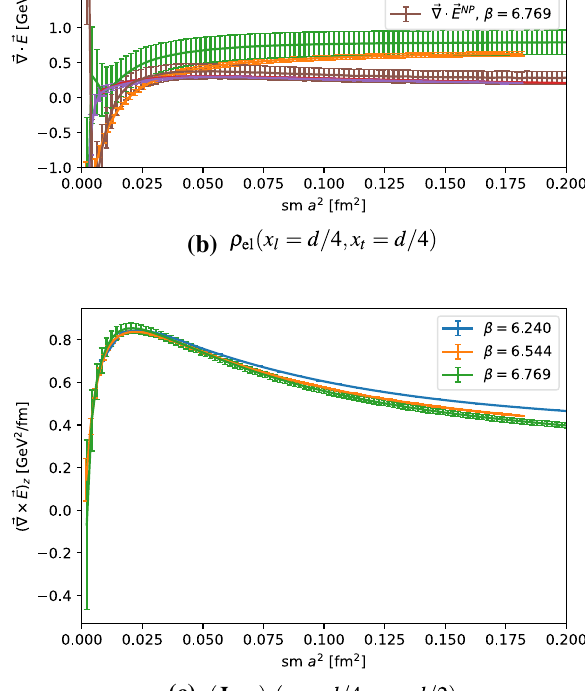
values of the coupling and of the optimal number of smearing steps, are in good agreement in the range of gauge couplings used. This is seen, for the non-perturbative field, in Fig. 4, ( x ) at a transverse plane x where E NP t x three values of β .